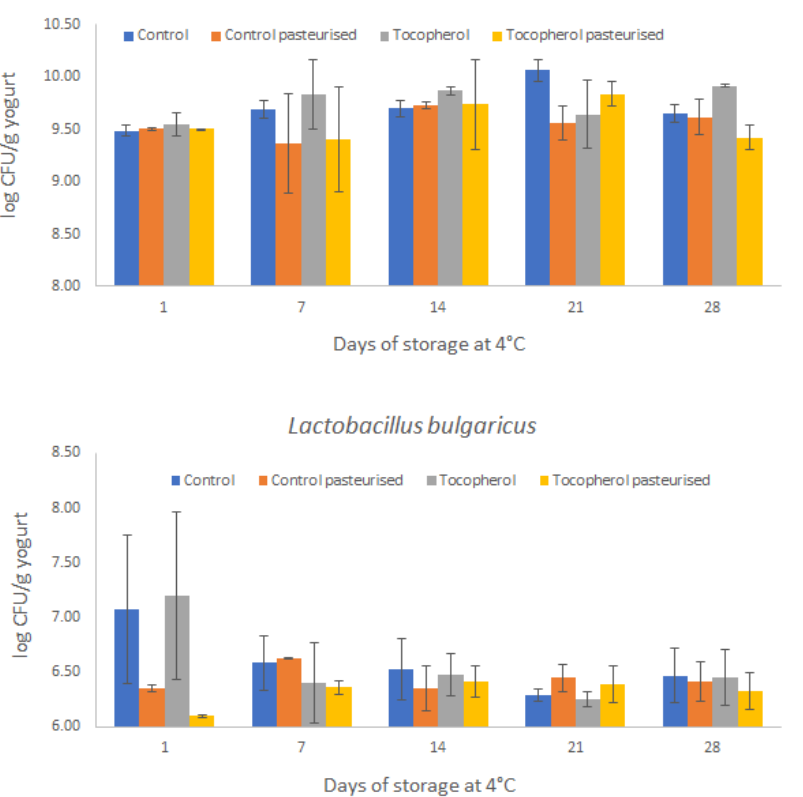
Figure 2. Viable counts of S. thermophilus and L. bulgaricus in yogurt-based beverages during 28 days of storage at 4 °C. Each point is the mean of two replicates from each batch (n = 4).